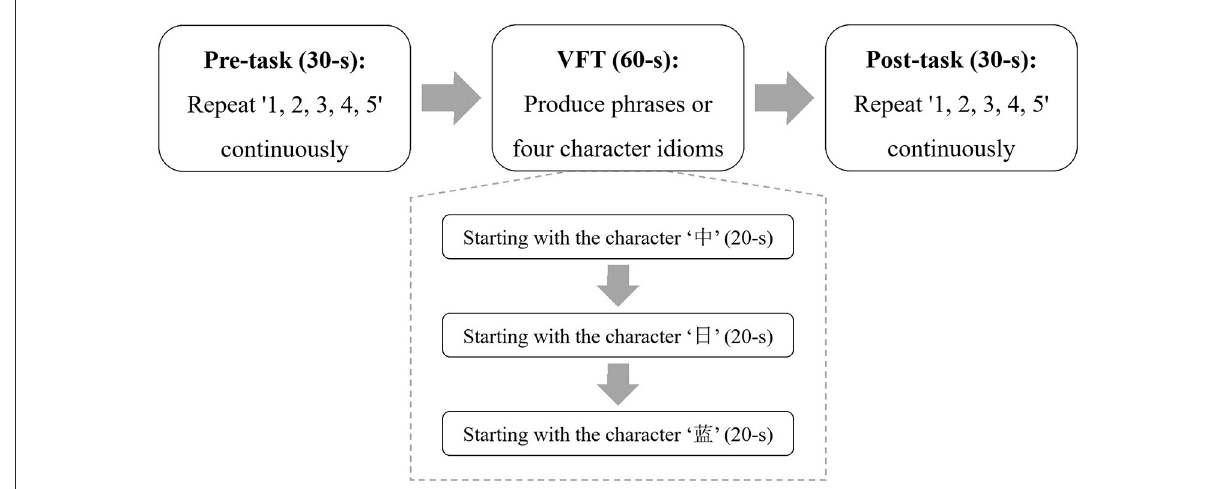
FIGURE1 The paradigm of the VFT. During the VFT, three Chinese characters were displayed on the screen for making as many phrases as